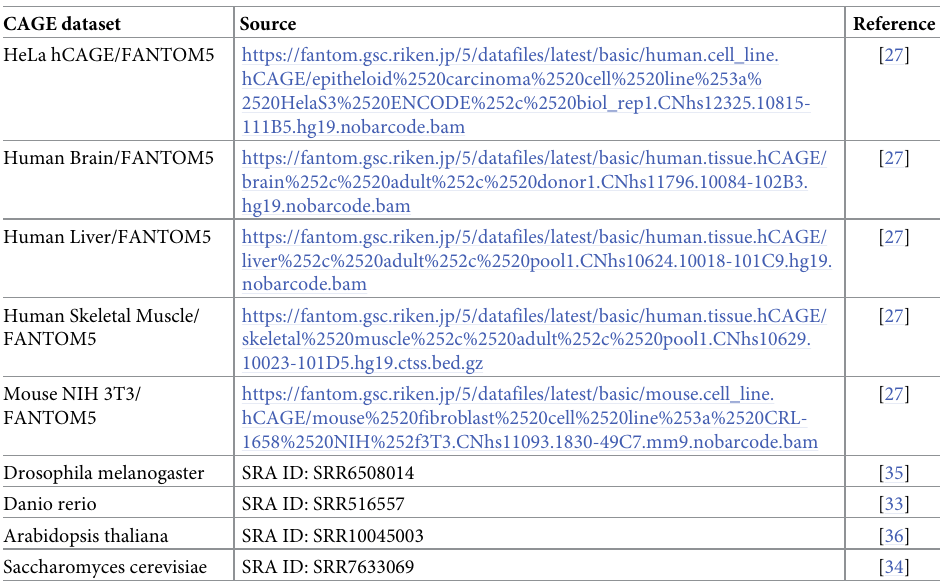
Table 2. Sources for CAGE